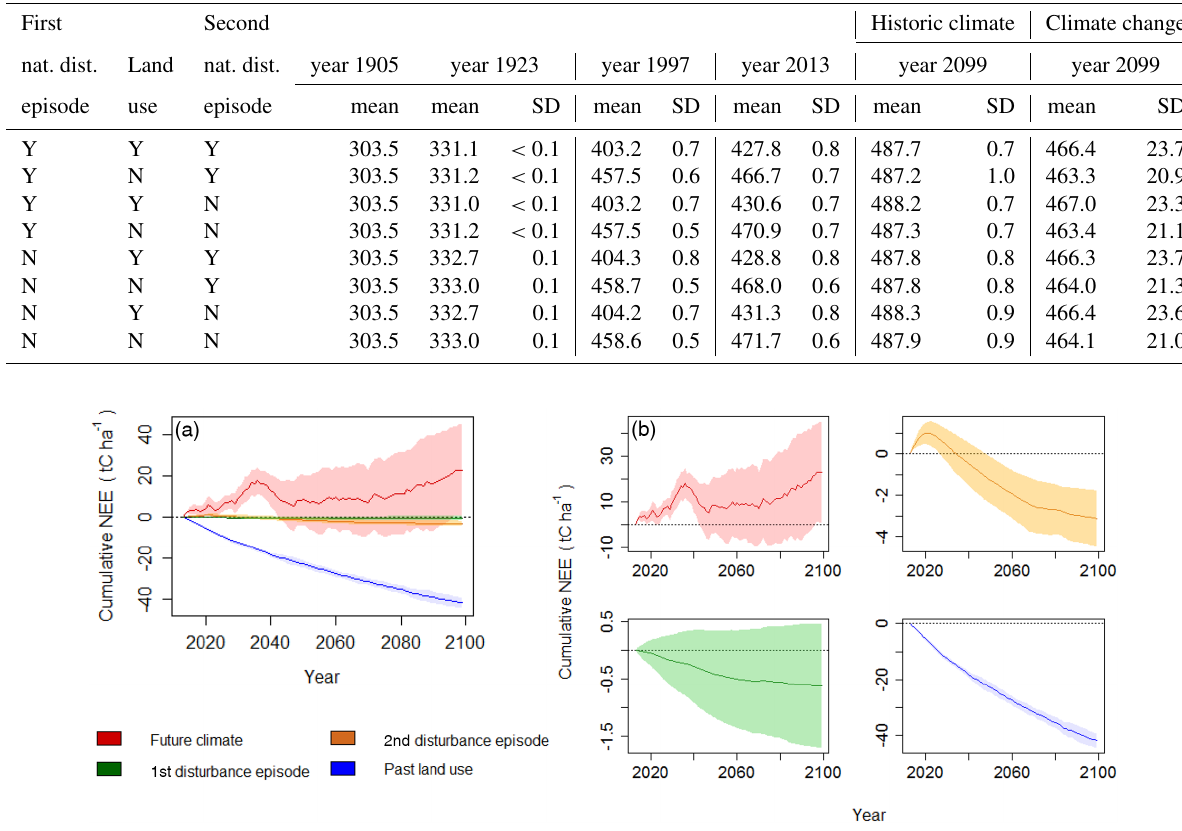
Figure 4. Scenarios of mean cumulative change in future net ecosystem exchange (NEE). Panel (a) shows the effects of all considered drivers of NEE change on the same scale while panel (b) zooms into the individual effect of each driver. Cumulative NEE was analyzed after the second disturbance episode (setting NEE to 0 in year 2013) to allow for the simultaneous representation of the long-term legacy effects of different past disturbance events (i.e., the first disturbance episode of 1917–1923 and the second of 2007–2013), land-use change (i.e., management ceased in 1997), and future climate change. Differences in NEE were derived from a factorial simulation experiment, comparing each factor to its baseline (e.g., future climate scenarios to baseline climate) while keeping all other factors constant. Shaded areas denote the standard deviation in NEE for the respective scenarios. NEE is the carbon flux from the ecosystem to the atmosphere (i.e., NEE =− NEP). Note that y -axis scales differ for each